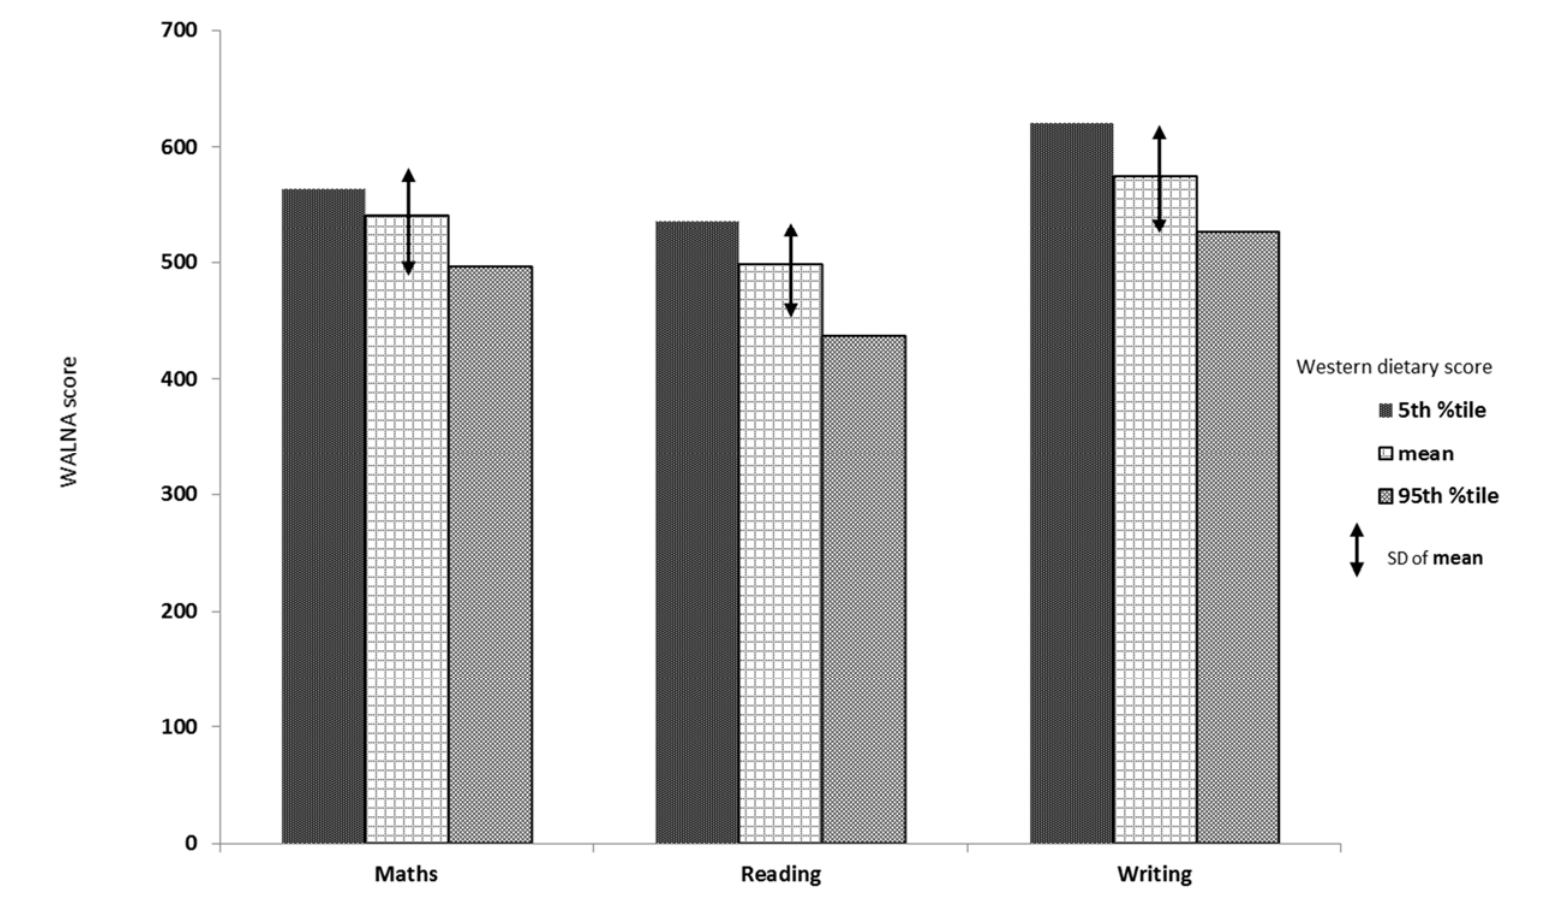
Figure 1. The differences in the predicted adjusted academic scores between the 5th percentile (lowest level) and 95th percentile (highest level) of the Western dietary pattern score in the Western Australian Pregnancy Cohort (Raine) Study at 14 years of